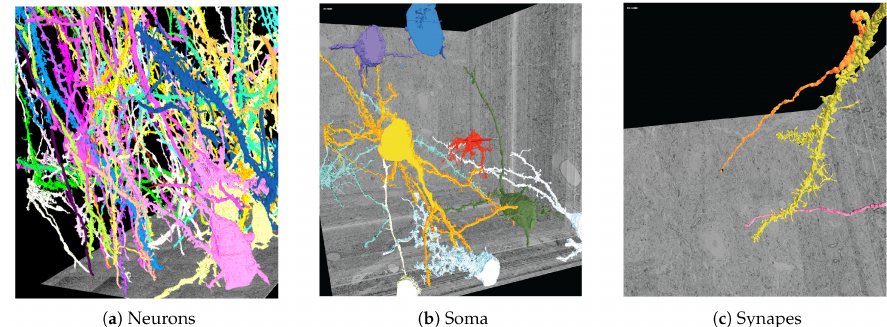
Figure 3. Interactive scenes with zoom, pan, and scroll visualize 3D polygonal mesh reconstructions of a connectomics data set in 3DXP with progressively rendered geometries: ( a ) Left image shows twenty neurons stretching through a 100 µ m 3 volume. ( b ) Cell bodies (soma) and ( c ) left image shows a dendrite with two synaptic connections. URL: https://github.com/rhoana/3dxp. Source: [36].